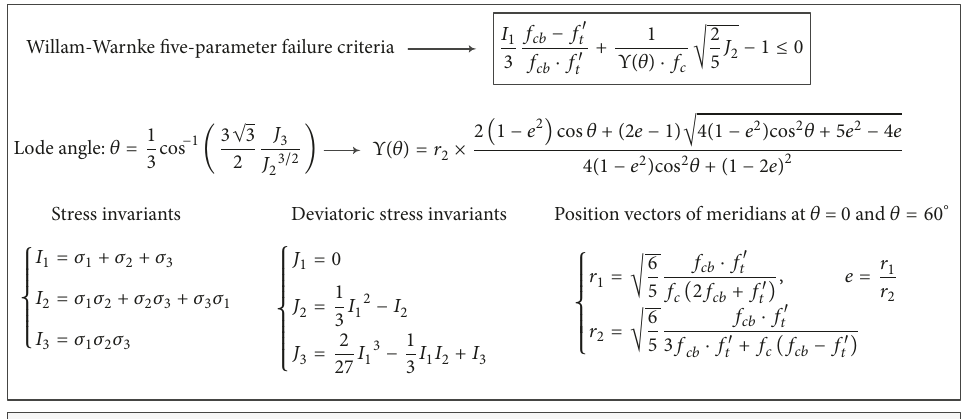
Figure 3: Formulation of failure criterion for concrete; adopted from